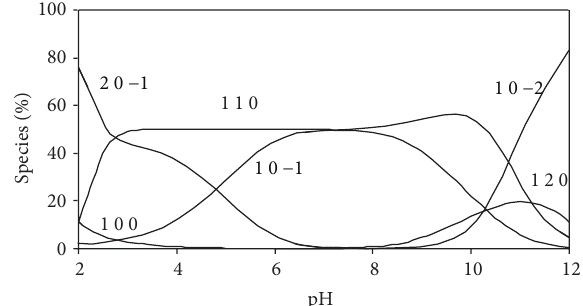
dimer (2 0 − 1) is assumed to form through dimerization of